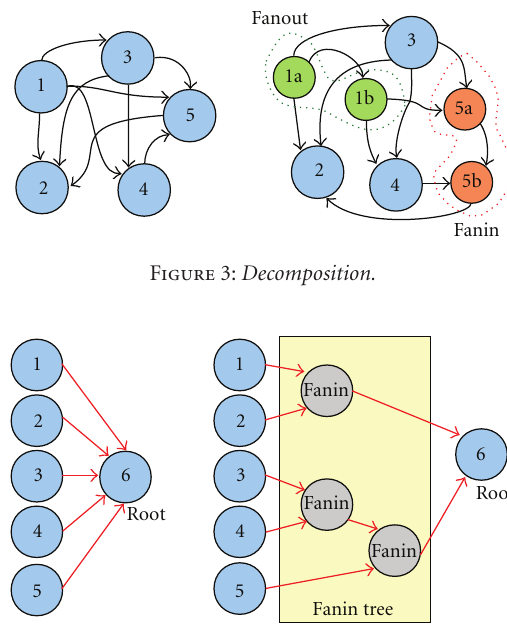
Figure 4: Fanin Decomposition tree example.